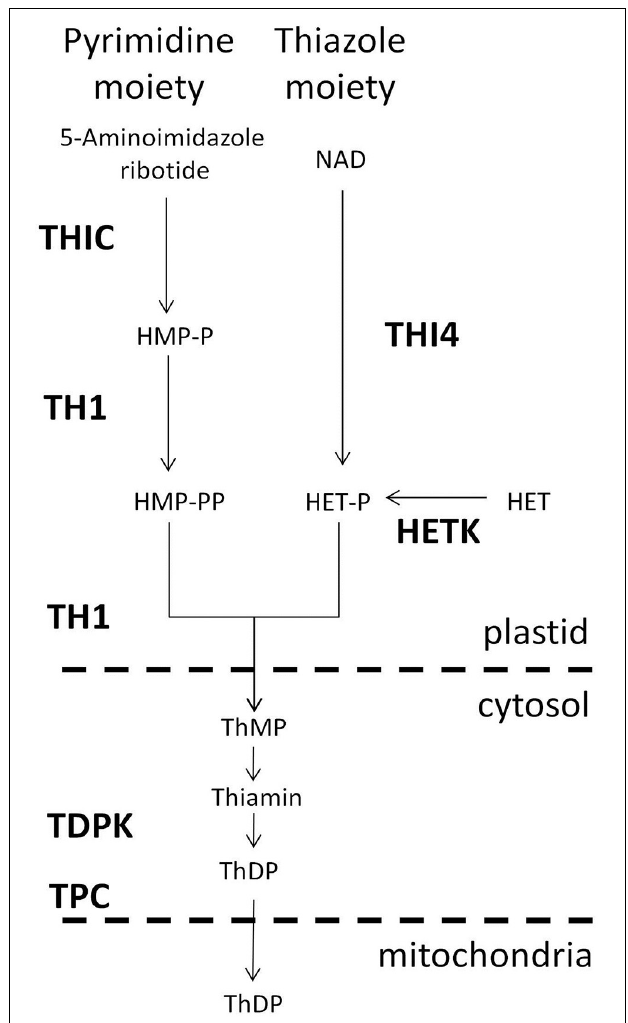
FIGURE 1 | Thiamin biosynthesis pathway in plants. Abbreviations (bold) used for enzyme and transport functions assigned to genes of Arabidopsis and maize ( Table 1 ): THIC, hydroxymethylpyrimidine phosphate synthase; THI4, thiazole biosynthetic protein; TH1,